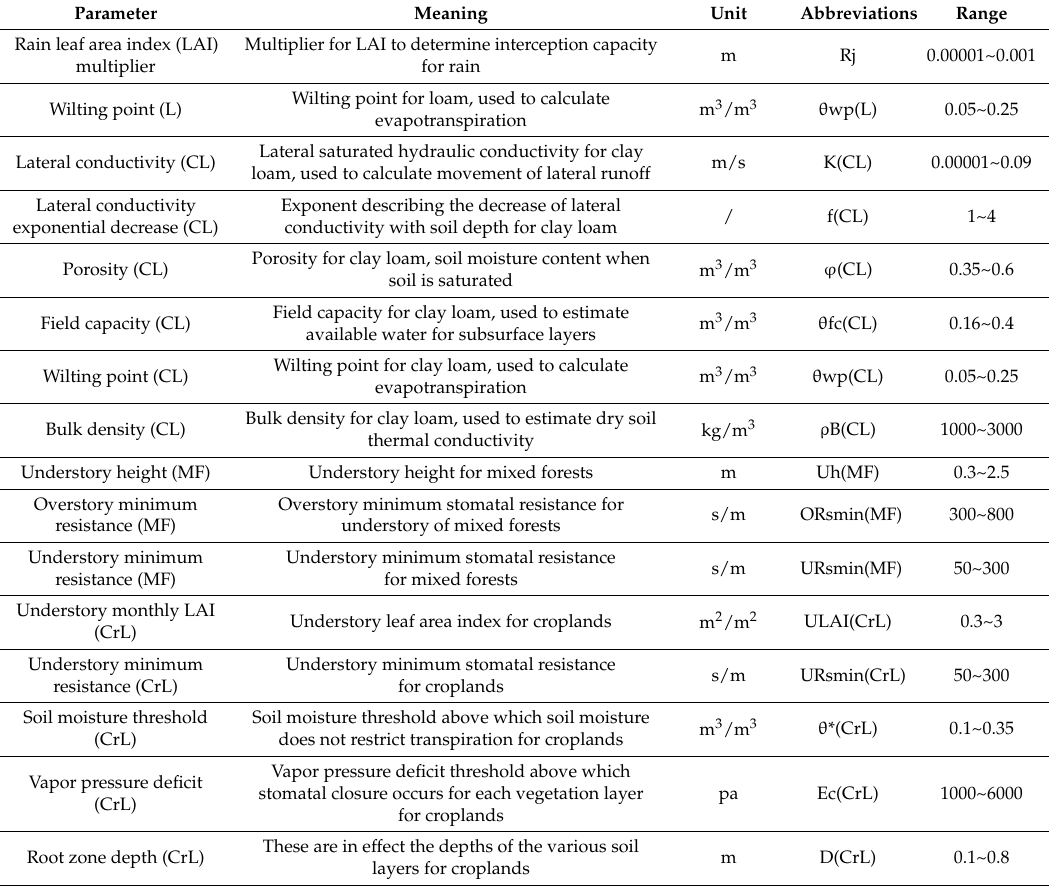
Table 1. Ranges, meaning, unit and abbreviation of 16 parameters of the DHSVM in Sobol’s sensitivity analysis.